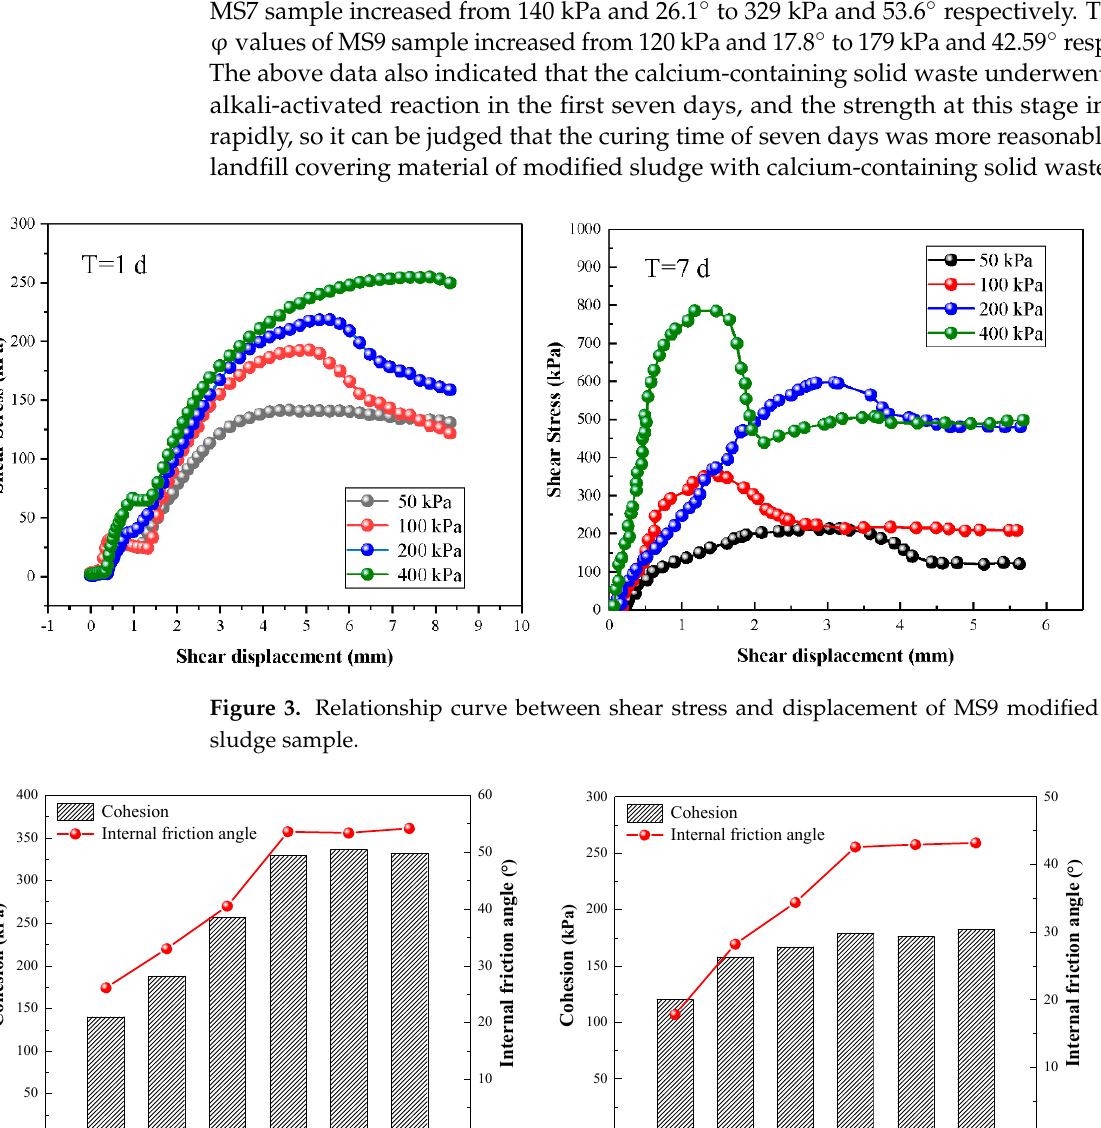
Figure 4. The cohesion and internal friction angle of modified dredged sludge samples. ( a ) MS7 sample, ( b ) MS9 sample.